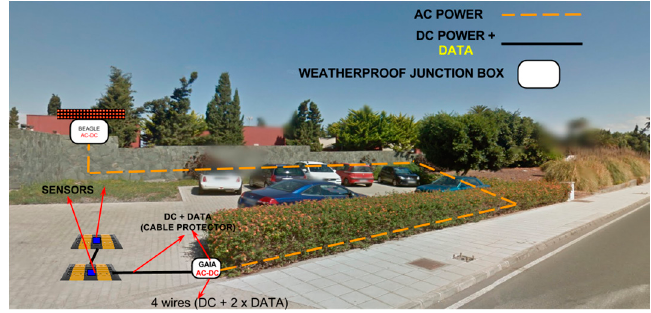
Figure 11. Deployment of prototype sensor system to monitor access to the parking area. The sensors are installed in the speed bumps.